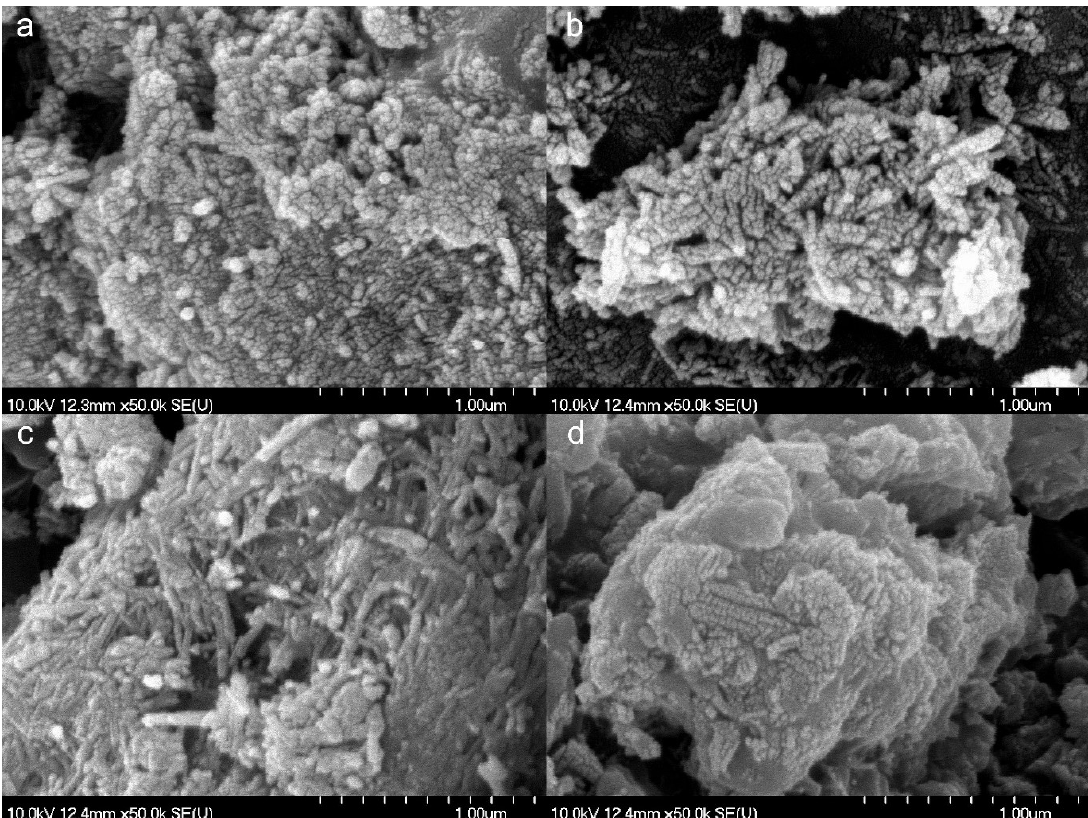
Figure 2. Scanning electron micrographs of the diltiazem hydrochloride (DiltTi) ( a ), diclofenac sodium (DicTi) ( b ), atenolol (ATNTi) ( c ) and hydrochlorothiazide (HCTTi) ( d ) composites.